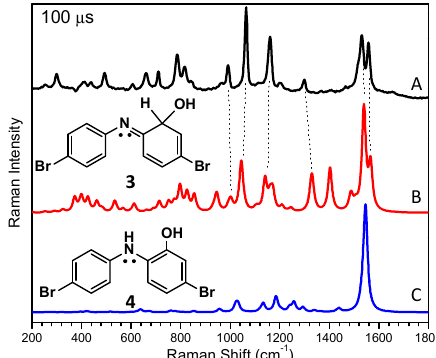
Figure 5. The ns-TR 3 spectrum at 100 µs (A) obtained after 266 nm photoexcitation of DN in a 1:1 MeCN:H 2 O is compared with the DFT predicted normal Raman spectrum of intermediate 3 (B) and product 4 (C).